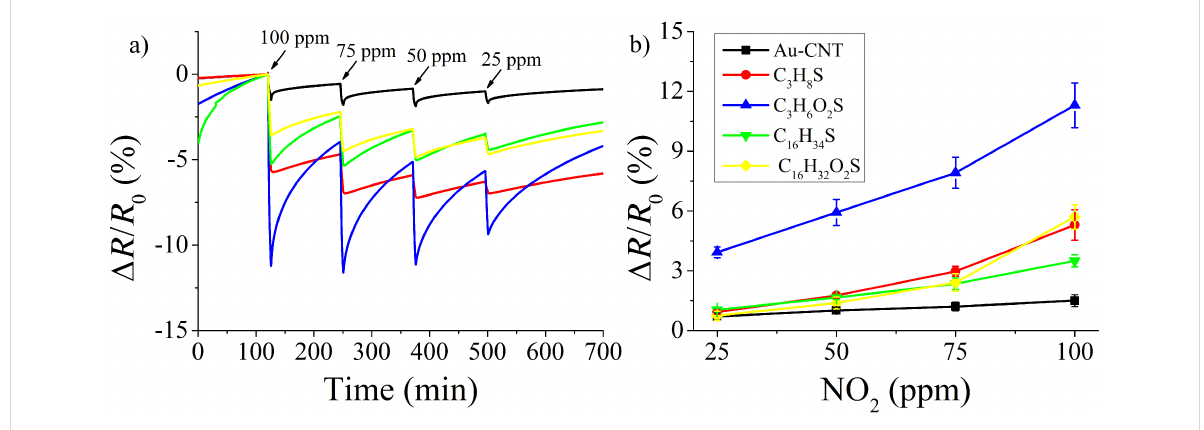
Figure 5: a) Sensor response to nitrogen dioxide exposure and recovery cycles in air, and b) calibration curves for the different nitrogen dioxide con- centrations tested.